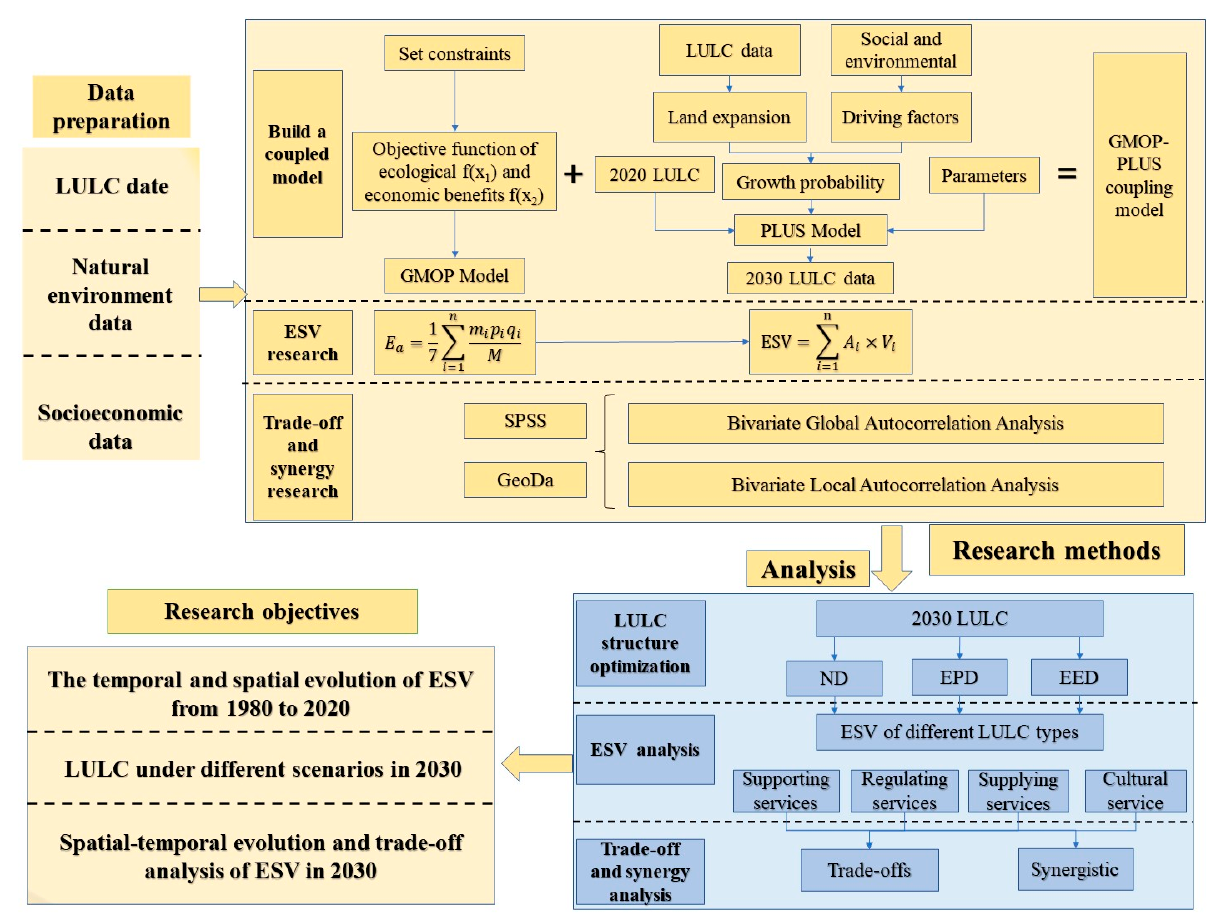
Figure 2. The research framework of this paper. LULC, Land use/cover; ESV, Ecosystem service value; ND, Natural development scenarios; EPD, Ecological priority development Scenario; EED, Balanced ecological and economic development; GMOP, Gray multi-objective optimization; PLUS, Patch-generating land-use simulation.